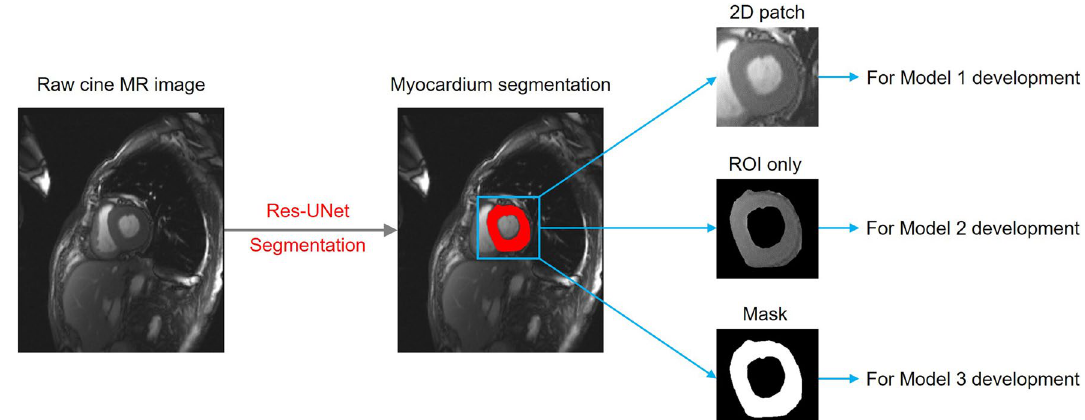
Fig. 2 Illustration of data pretreatment for the development of Model 1, Model 2 and Model 3. ROI—region of interest